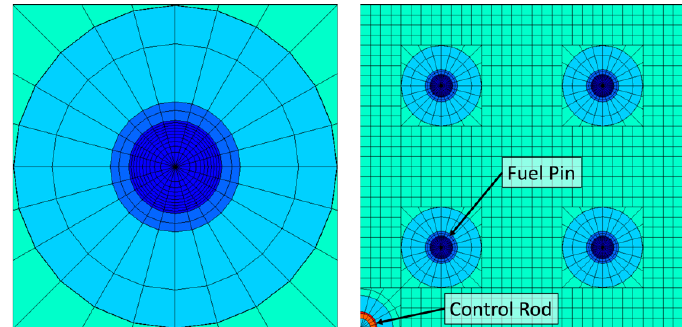
Figure 1. MPACT model meshing in the fuel pin (left) and charge pan (right).